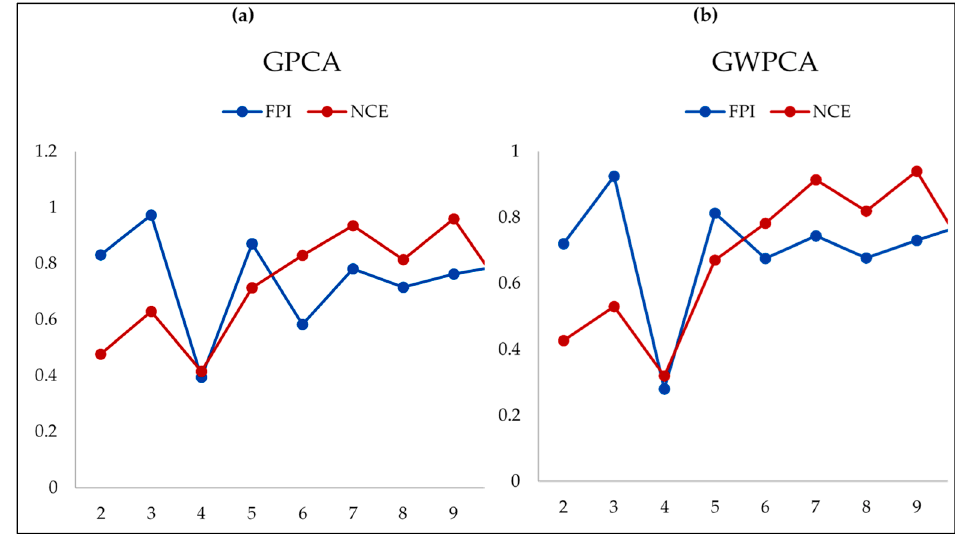
Figure 7. Calculated indices for locating the best clusters in the research region based on the GPCA score ( a ) and GWPCA score ( b ).